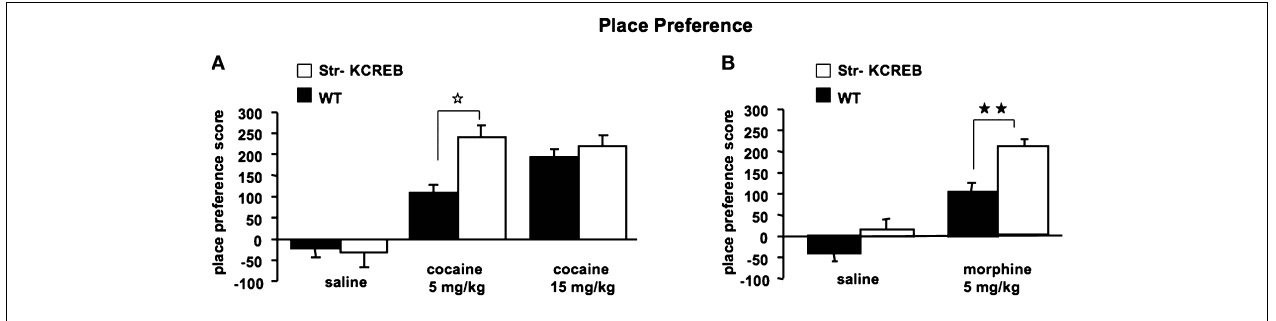
FIGURE 7 | Enhanced reward-related learning in str-KCREB mice. (A) str-KCREB mice showed enhanced conditioned place preference to cocaine. Conditioned place preference is expressed as difference between post-and pre-conditioning time spent in the drug-paired compartment of the training apparatus ( n : saline 10,10; 5 mg/kg i.p. cocaine 15,15; 15 mg/kg i.p.